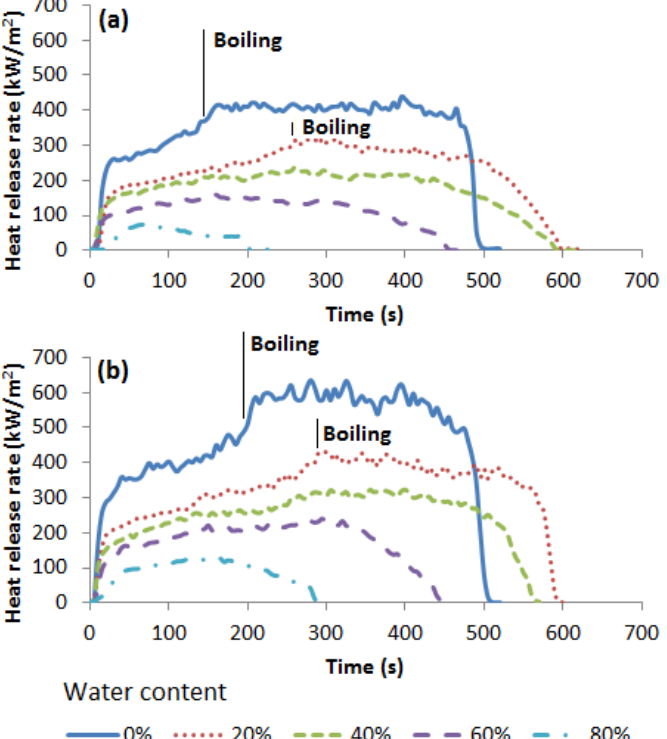
Figure 2. Dependency of the heat release rate of investigated fuels on the water content: ( a ) Dependency of the heat release rate of methanol on the water content; ( b ) Dependency of the heat release rate of ethanol on the water content.